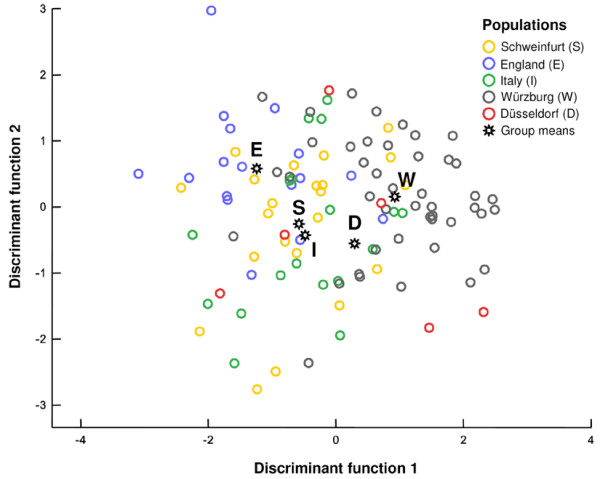
Discriminant analysis of geographical variation of the sex-pheromone on the regional scale. Despite some overlap, the populations are significantly separated (data set 2, five populations, C25-type only; see Table 1 and text for details).